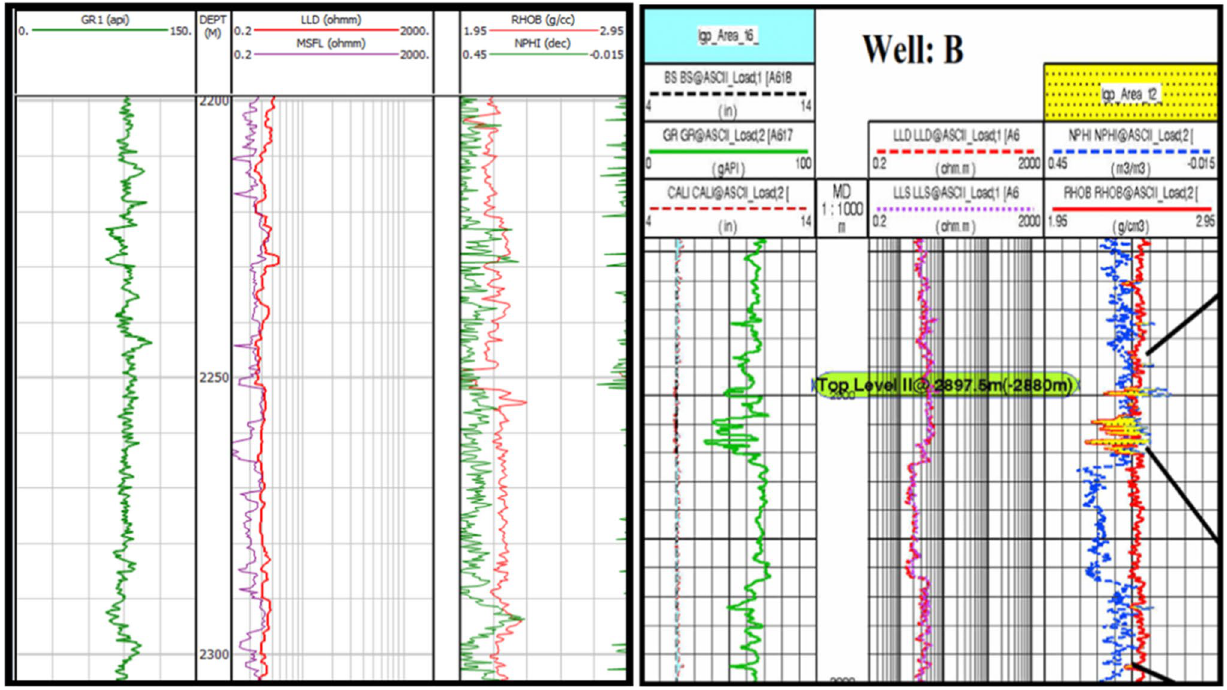
Fig. 15 To the left the Well_1 logs and to the right the low-resistivity well case (Anwar et al. 2002), the gamma ray logs are very close in both wells, but the resistivity are different, the resistivity of the low